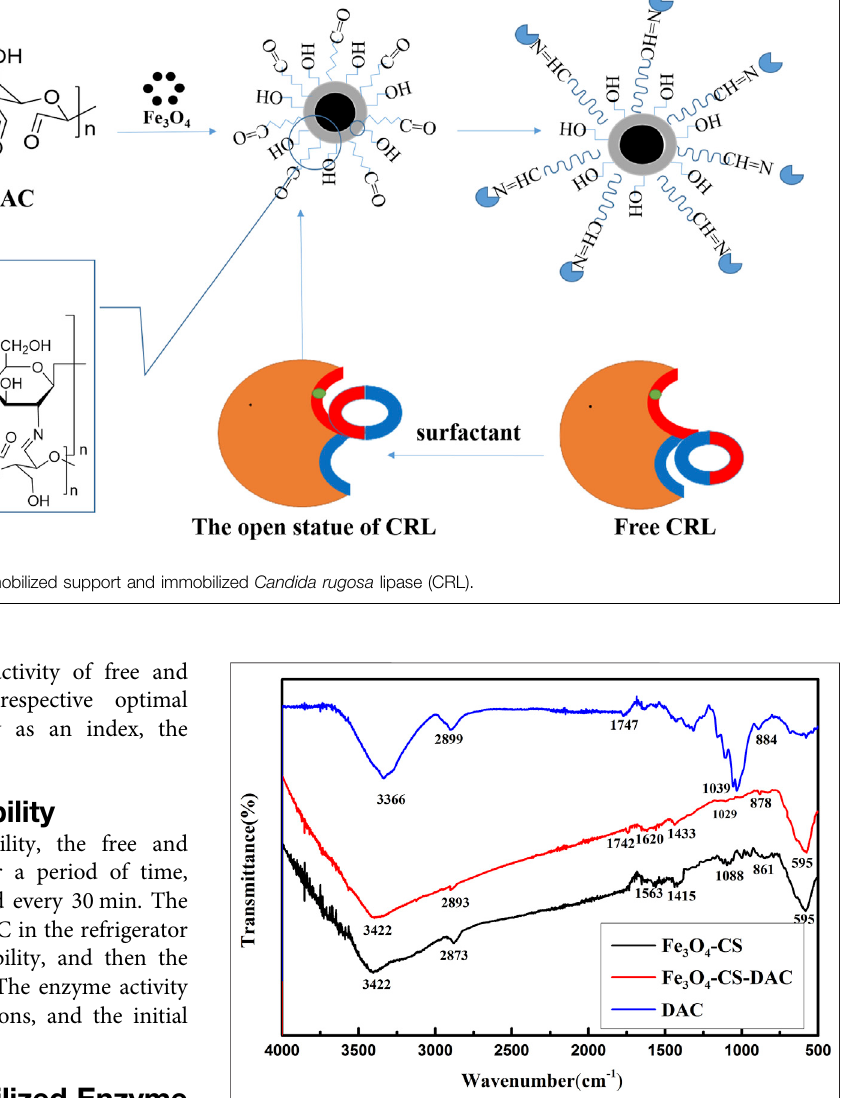
FIGURE 2 | FT-IR spectrum of